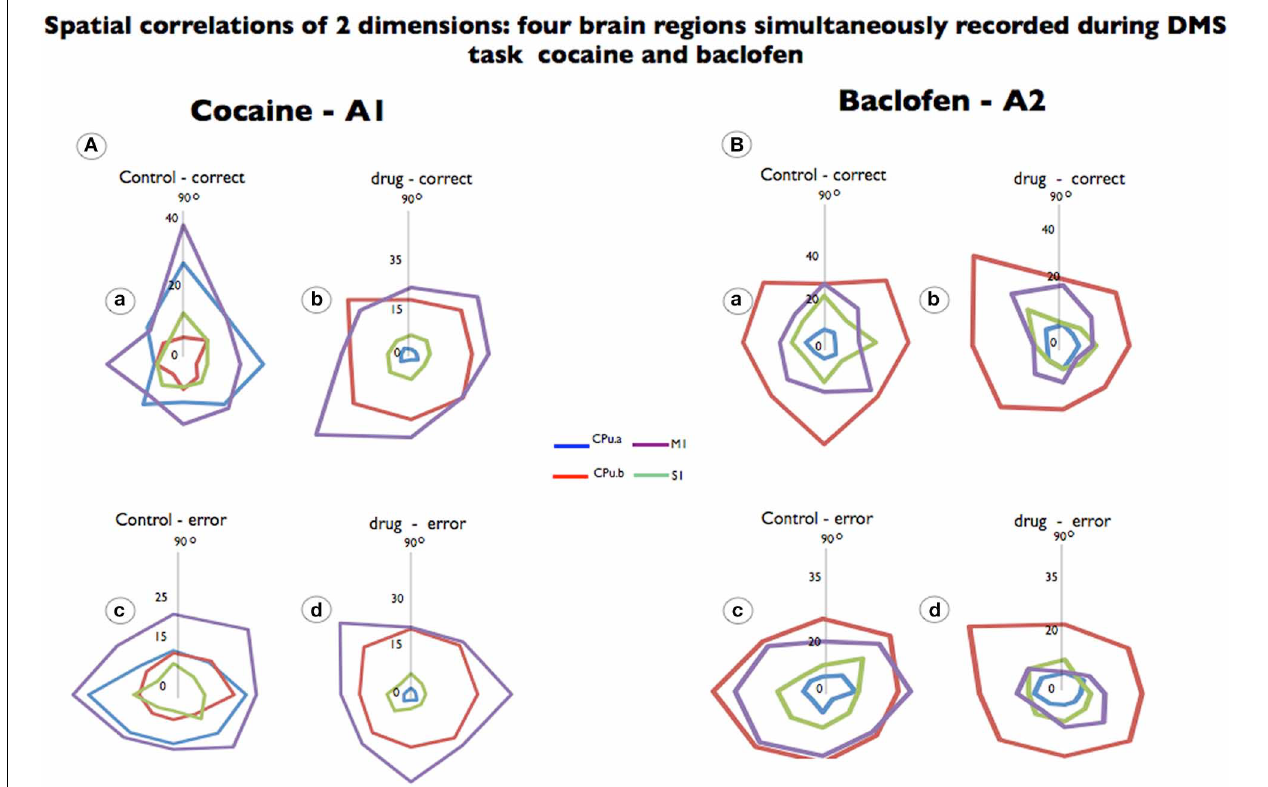
FIGURE 2 | Spatial tuning of firing from each brain region simultaneously recorded during DMS task performance. Recordings are shown for the same neurons recorded prior to drug administration (control) and after cocaine or baclofen injection ( Figure 1B ). (A) Shows color-coded directional spatial tuning plots of the task-related discharges of cells recorded in the rostromedial striatum (CPu.a and CPu.b) and the primary motor and sensory cortices (S1 and M1) at the indicated Cartesian (x-y) hand coordinates calculated for the eight horizontal planes